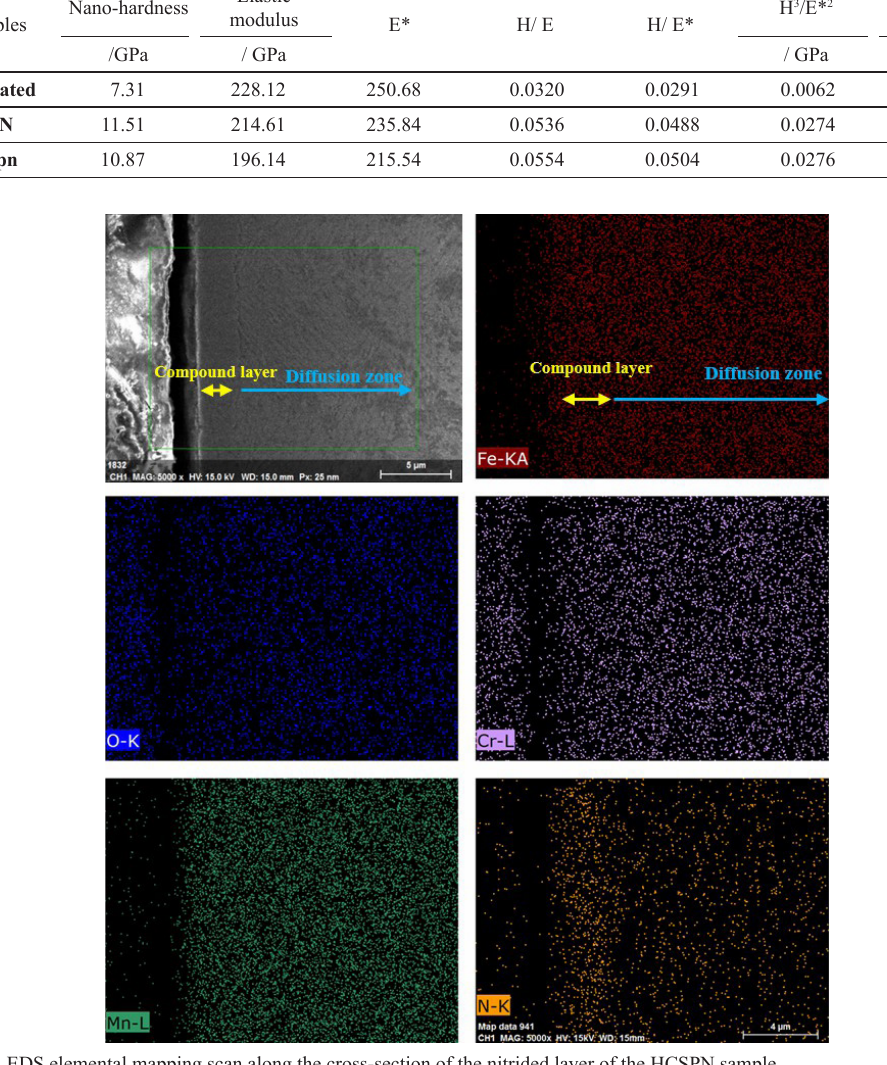
Table 2. Surface nano-hardness and micro-hardness of the different samples.